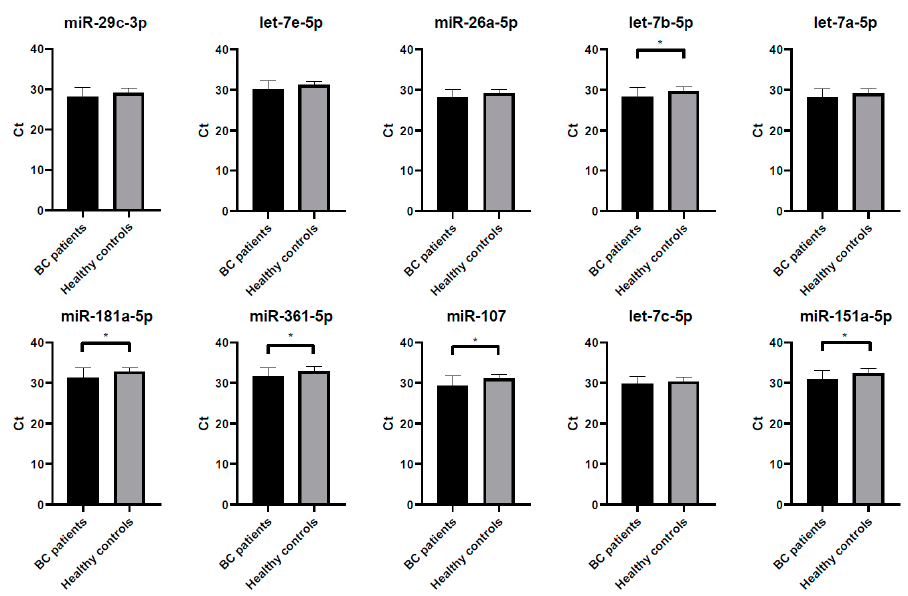
Figure 5. Differences in expression levels of the candidate miRNA normalizers selected by the comprehensive ranking of RefFinder between BC patients and controls. Expression levels are represented as Ct values and error bars represent standard deviation. Unpaired T-test: * p < 0.05.